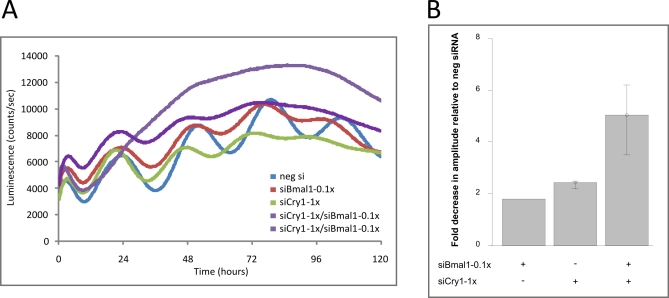
Compensation in Nonparalogous Genes May Contribute to Oscillator Robustness(A) U-2 OS cells transfected with siRNAs targeting Bmal1 or Cry1, individually or in combination as indicated, were synchronized, and luminescence levels were measured over 5 d. Data are representative of three independent biological replicates. Note that two examples are shown for the siCry1/siBmal1 combination knockdown.(B) Median and ranges of amplitude following single or combinatoric perturbation. The amplitude of the circadian signal was estimated using continuous wavelet decomposition and averaged across three replicates in three independent experiments. The median and range of the fold changes relative to the negative siRNA control are plotted. Both individual siRNA treatments are significantly down-regulated relative to the negative siRNA controls (p < 0.05, Mann-Whitney test), and the siCry1/siBmal1 double knockdown is also significantly down-regulated relative to siCry1 (p < 0.05, Mann-Whitney test).